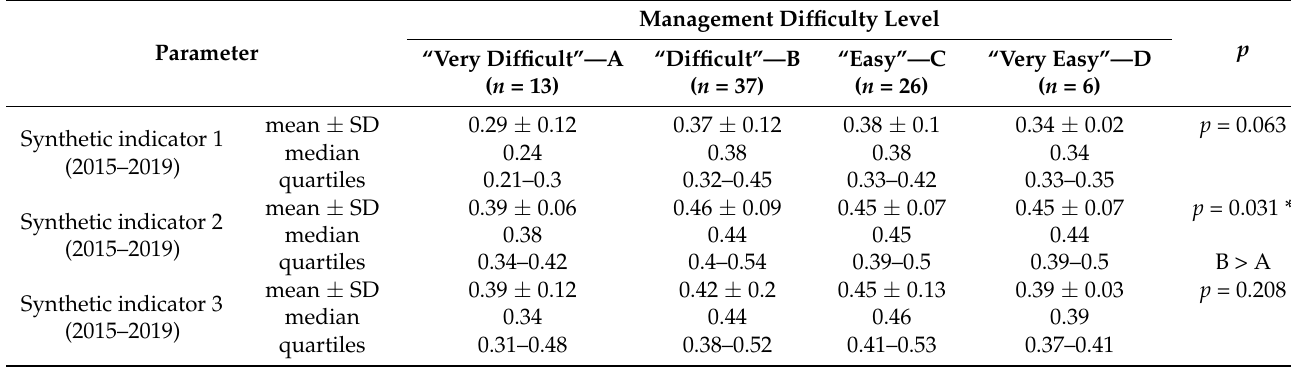
Table 9. Relationships between the synthetic indicators and forest district categories distinguished on the basis of manage- ment